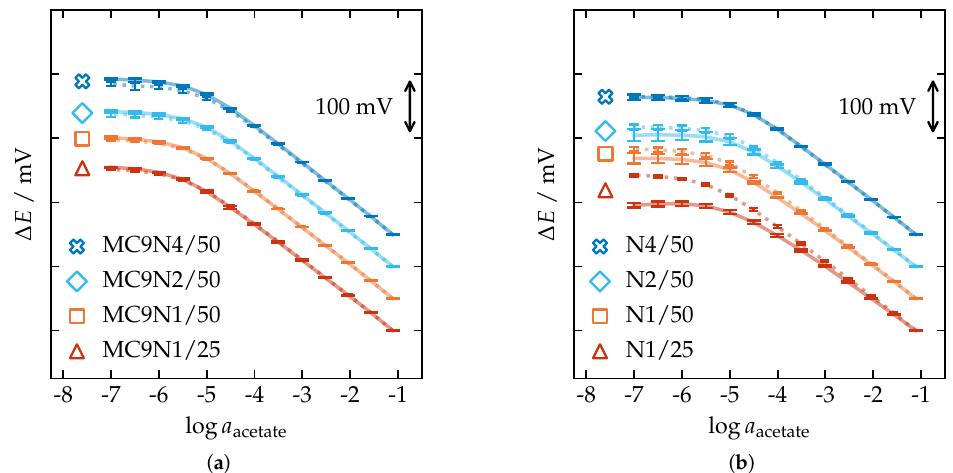
Figure A5. Potentiometric calibrations of ( a ) sensors incorporating MC9 and ( b ) control sensors. The membranes were all plasticized with o -NPOE. Potentials have been adjusted to separate membranes and so that each sensor in a group starts at the same potential at log a = standard deviations. PVC- and PCTFE-shelled sensors are shown as solid lines with wide error bars and dotted lines with narrow error bars, respectively. See Table 1 for membrane compositions.